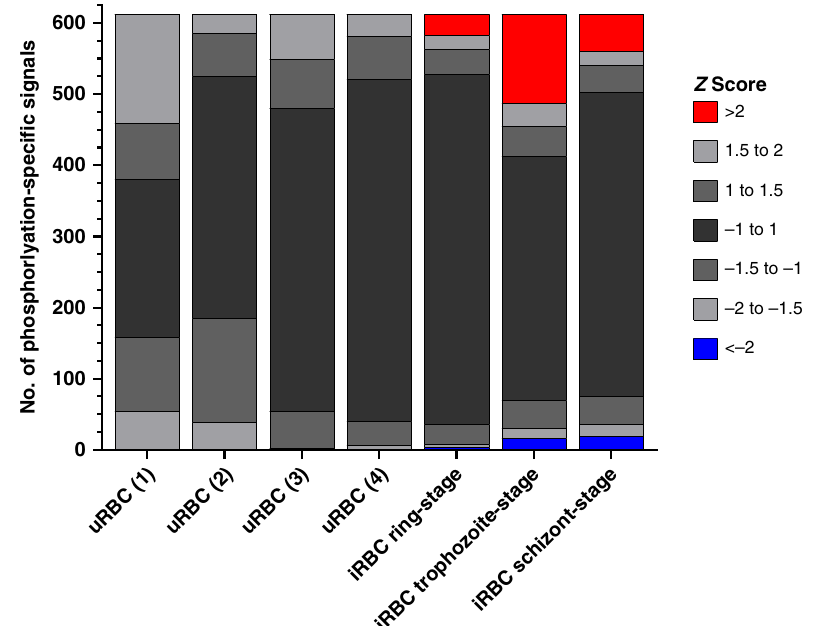
Fig. 1 Distribution of Z -scores for each sample. All antibody microarray signals from each sample (four from uRBCs and the mean signal for each iRBC harbouring parasites at the ring ( n = 3), trophozoite ( n = 3) and schizont stage ( n = 2)) were compared with the uninfected erythrocyte mean value for each signal, and the Z -score determined for each phosphorylation-speci fi c signal. The Z -score is de fi ned as the number of SDs from the uRBC mean for each sample; a positive or negative value indicates the direction of the signal (increase or decrease, respectively) from the uRBC mean. No signals from the uRBC samples ( n = 4) had associated Z -scores above 2 or below − 2, whereas the three iRBC time points showed clear variations from uRBCs. Source data are provided as a Source Data fi